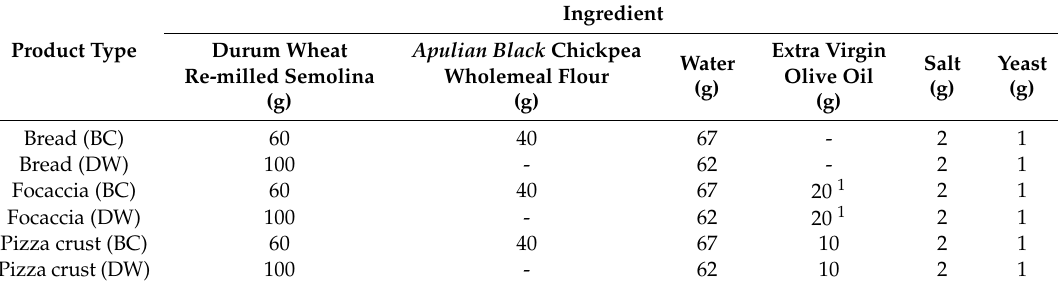
Table 1. Formulation of bread, focaccia, and pizza crust, given for 100 g of flour. DW =